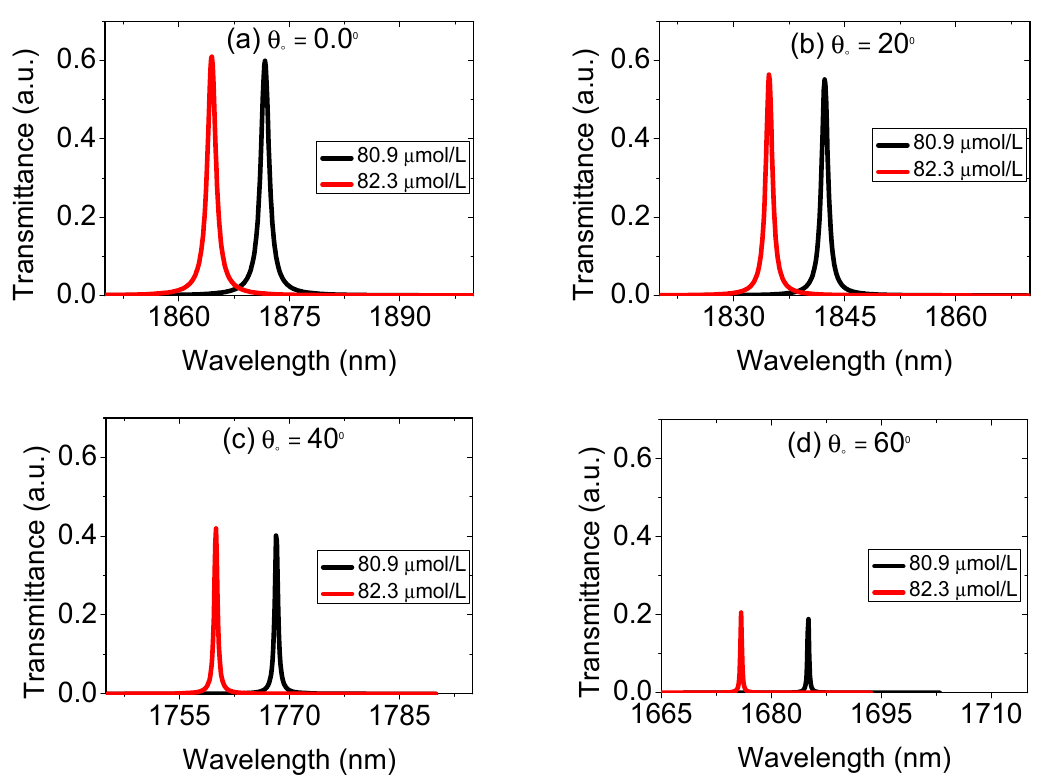
length, the interplanar spacing, the effective index of refractive, and the angle of incidence, respectively.